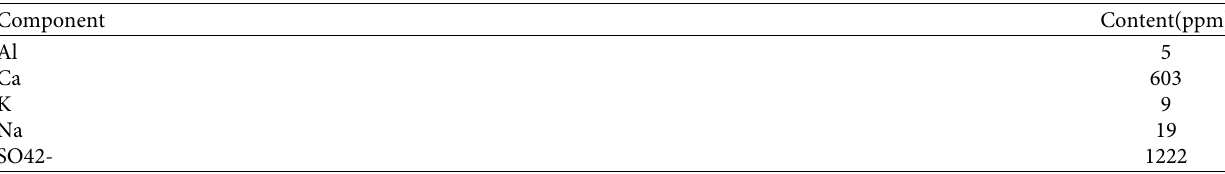
Table 12: Soaking solution composition.